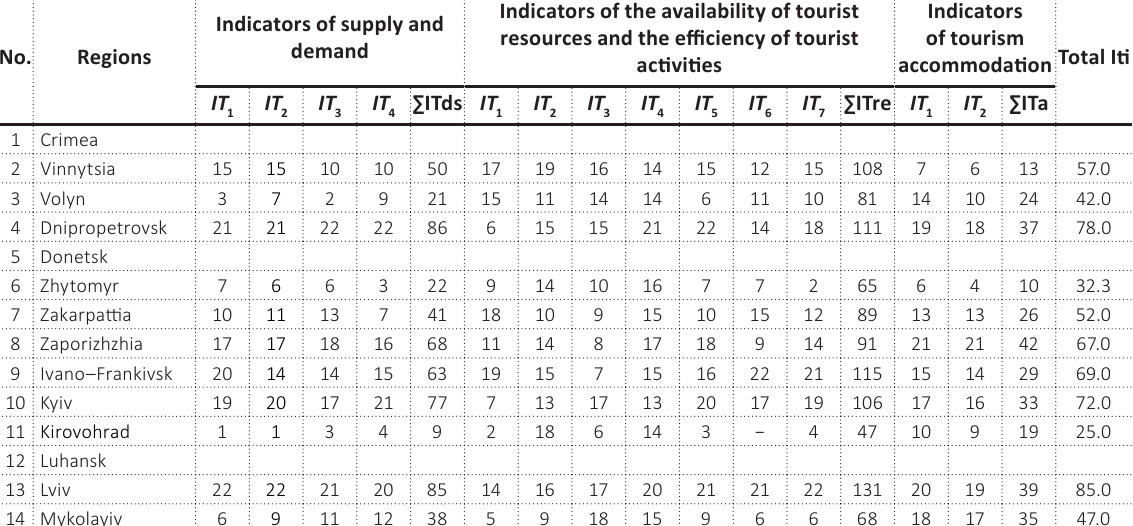
Table H1. Ranking positions of Ukraine’s regions according to their provision with tourist resources (supply and demand, availability of tourist resources, efficiency of tourist activities,